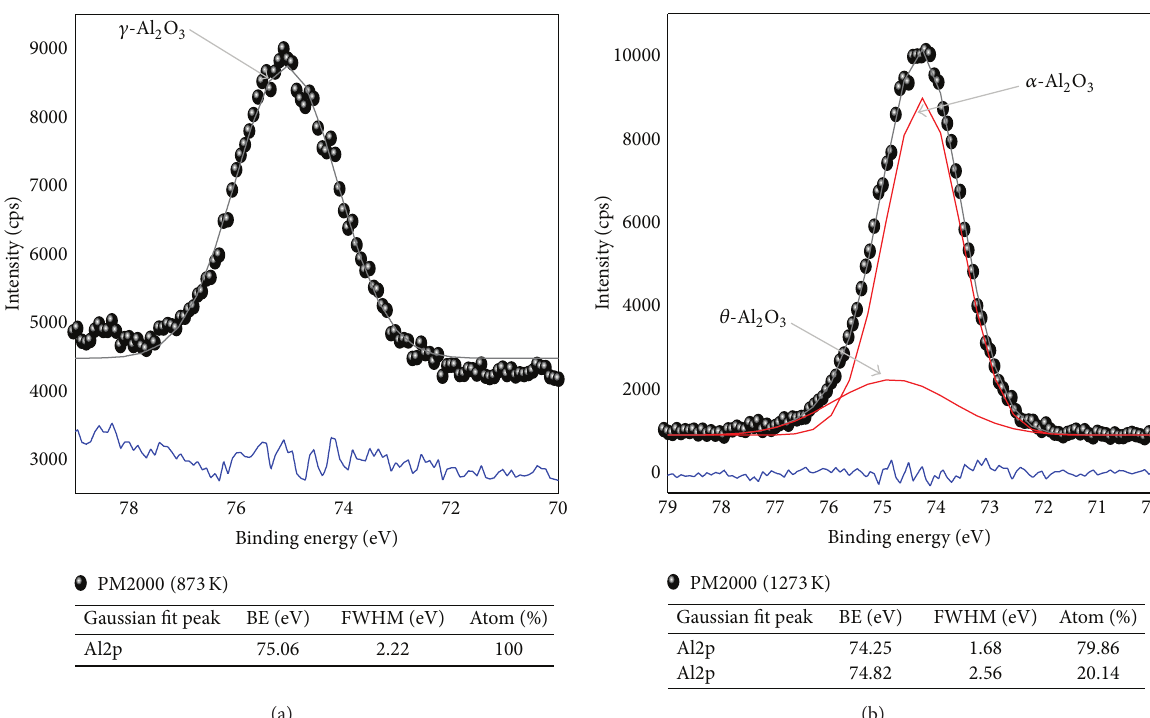
Figure 8: Single Al2p peak of oxidized PM2000 at 873 K (a) and decomposed Al2p peak of oxidized PM2000 at 1273 K